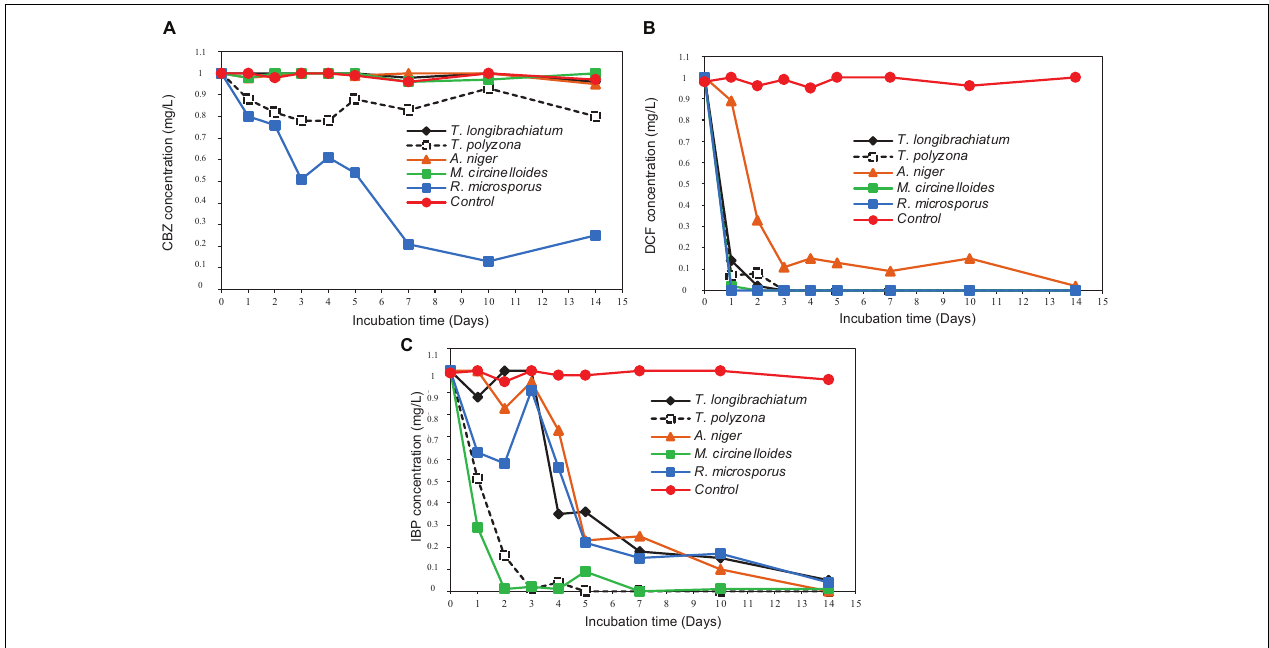
FIGURE 6 | Simultaneous removal of PhCs from liquid media in ABF: (A) CBZ; (B) DCF; and (C)